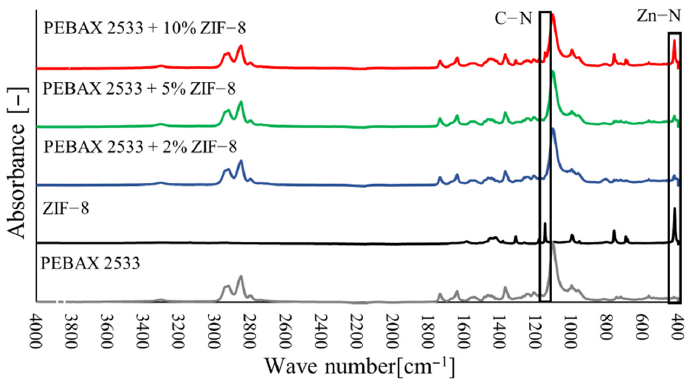
Figure 10. FTIR analysis of membranes containing ZIF − 8 in different concentrations.